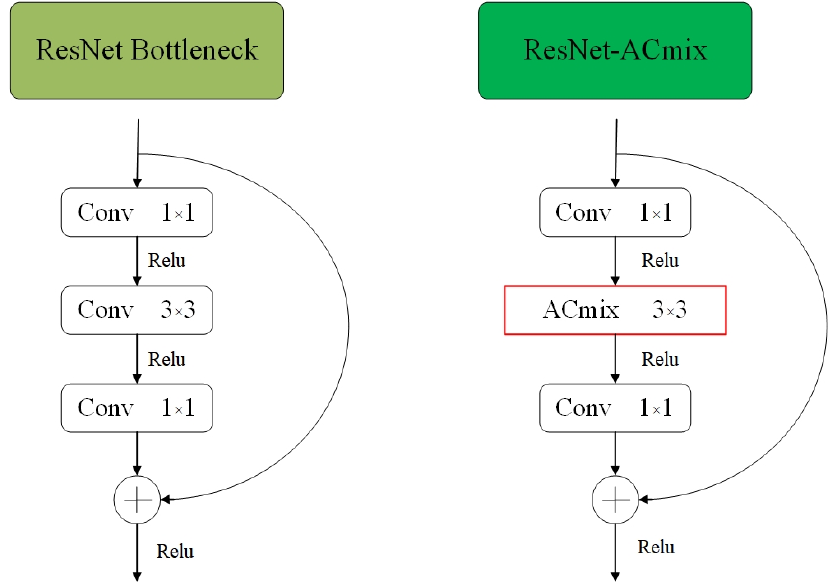
Figure 2. The structure diagram of ResNet-ACmix module ( left : ResNet; right : ResNet-ACmix).